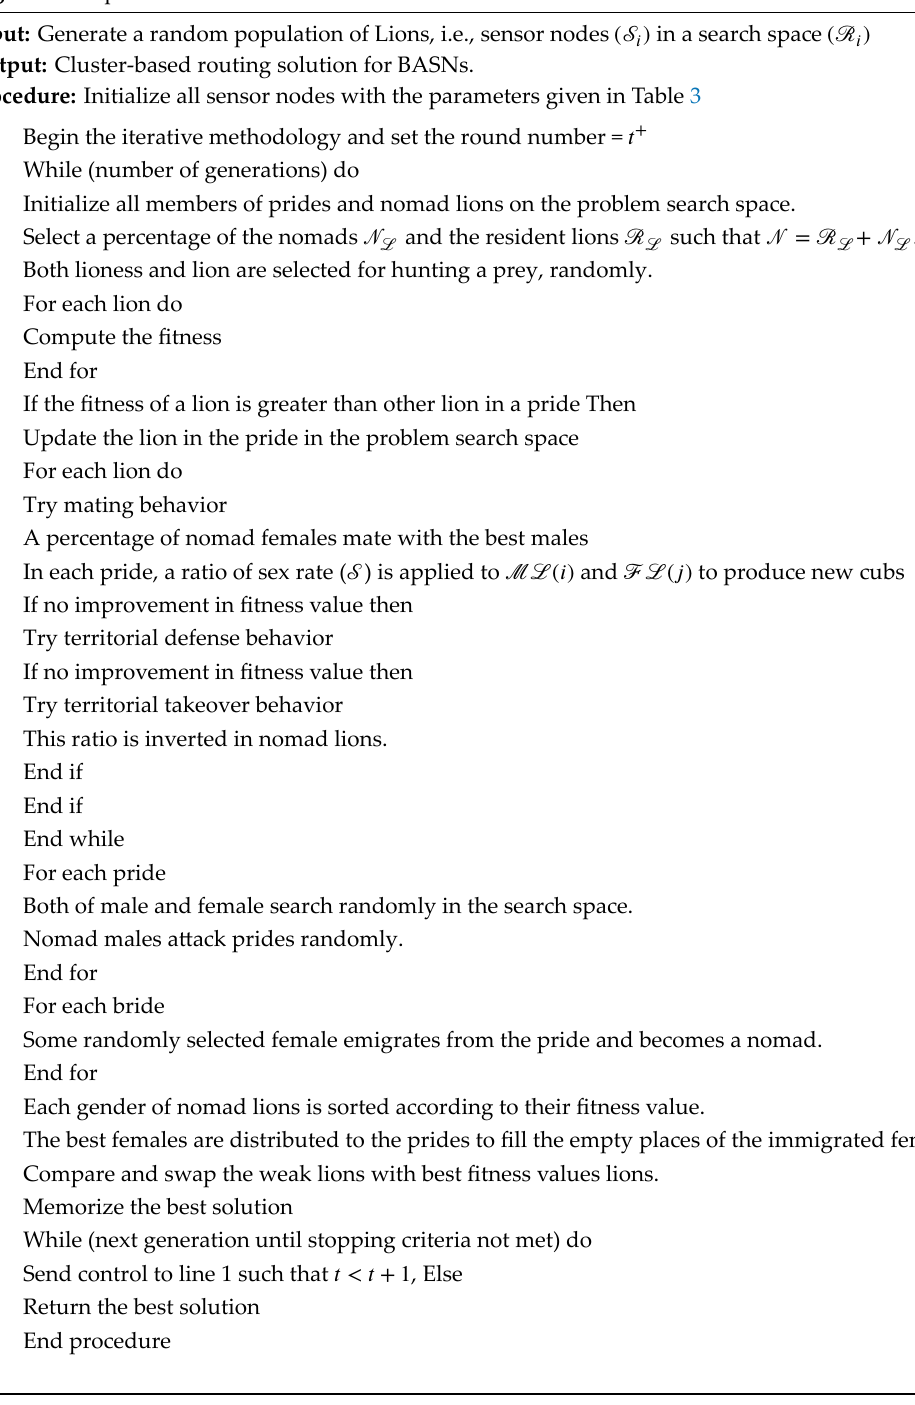
Algorithm 1: pseudo code for LMO in